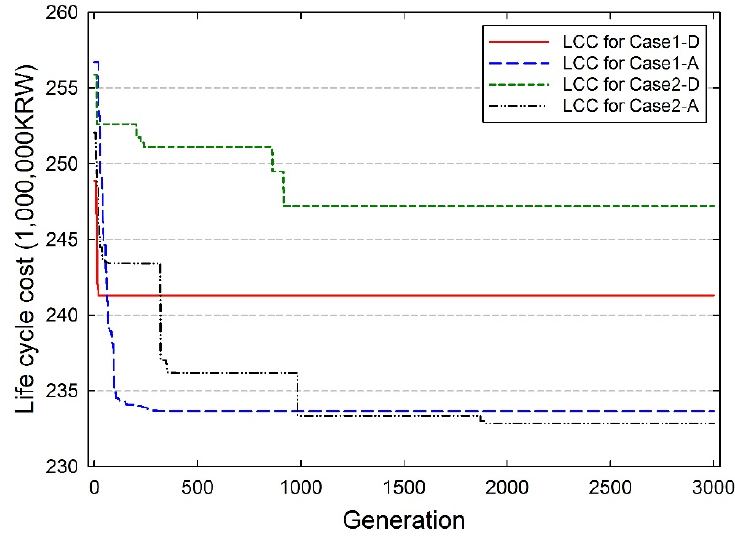
Figure 5. Evolution of the objective functions for each case.